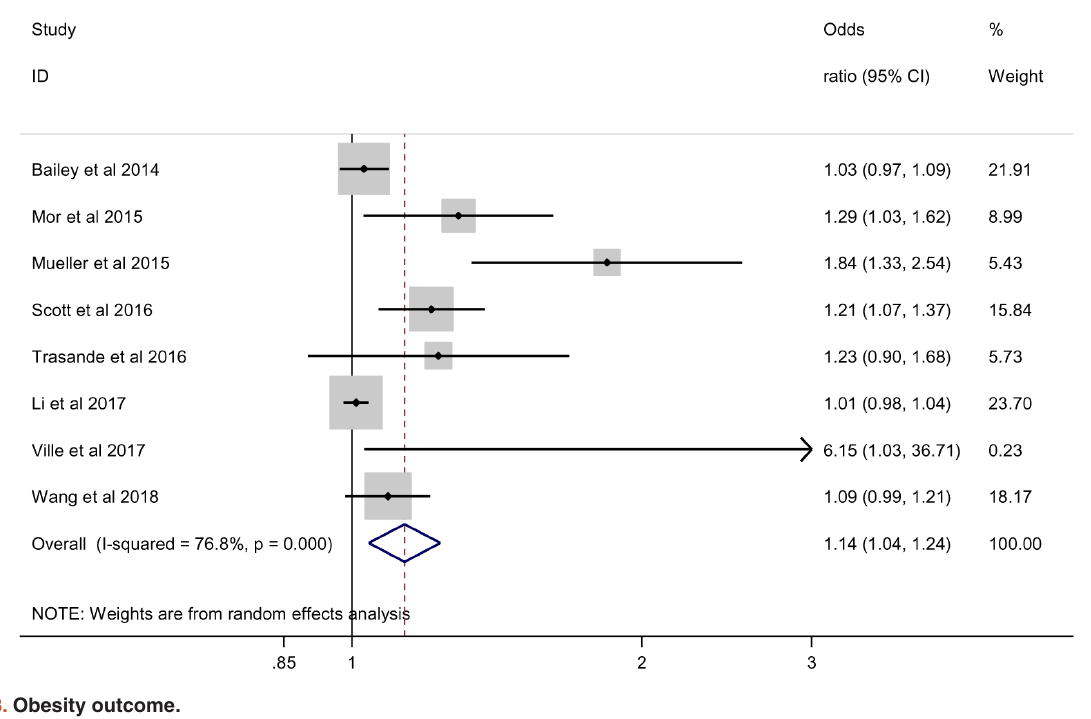
Figure 3. Obesity outcome.